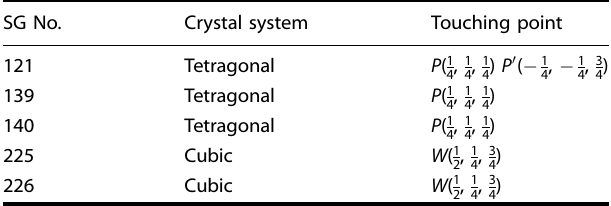
Table 1. SGs hosting the proposed symmetry-enforced nodal-chain